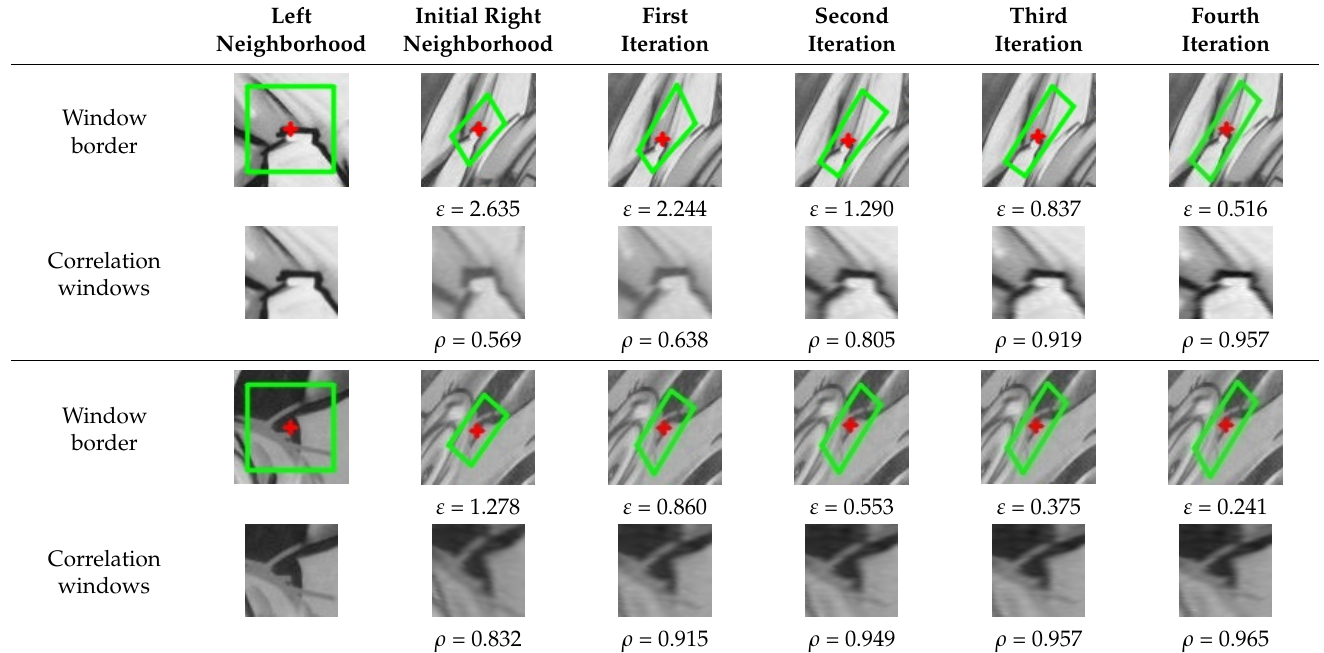
Table 3. Conjugate neighborhoods, affine transform error ε (pixels), and correlation coefficient ρ are corrected by DLT-LSM iterations.